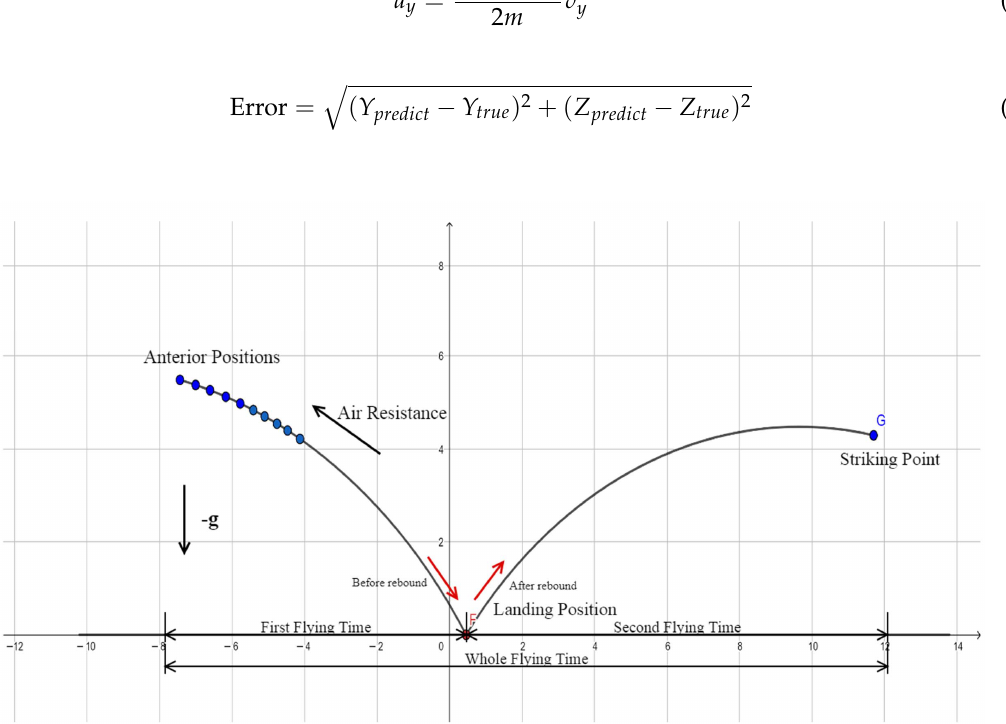
Figure 17. Striking point prediction using physical model.